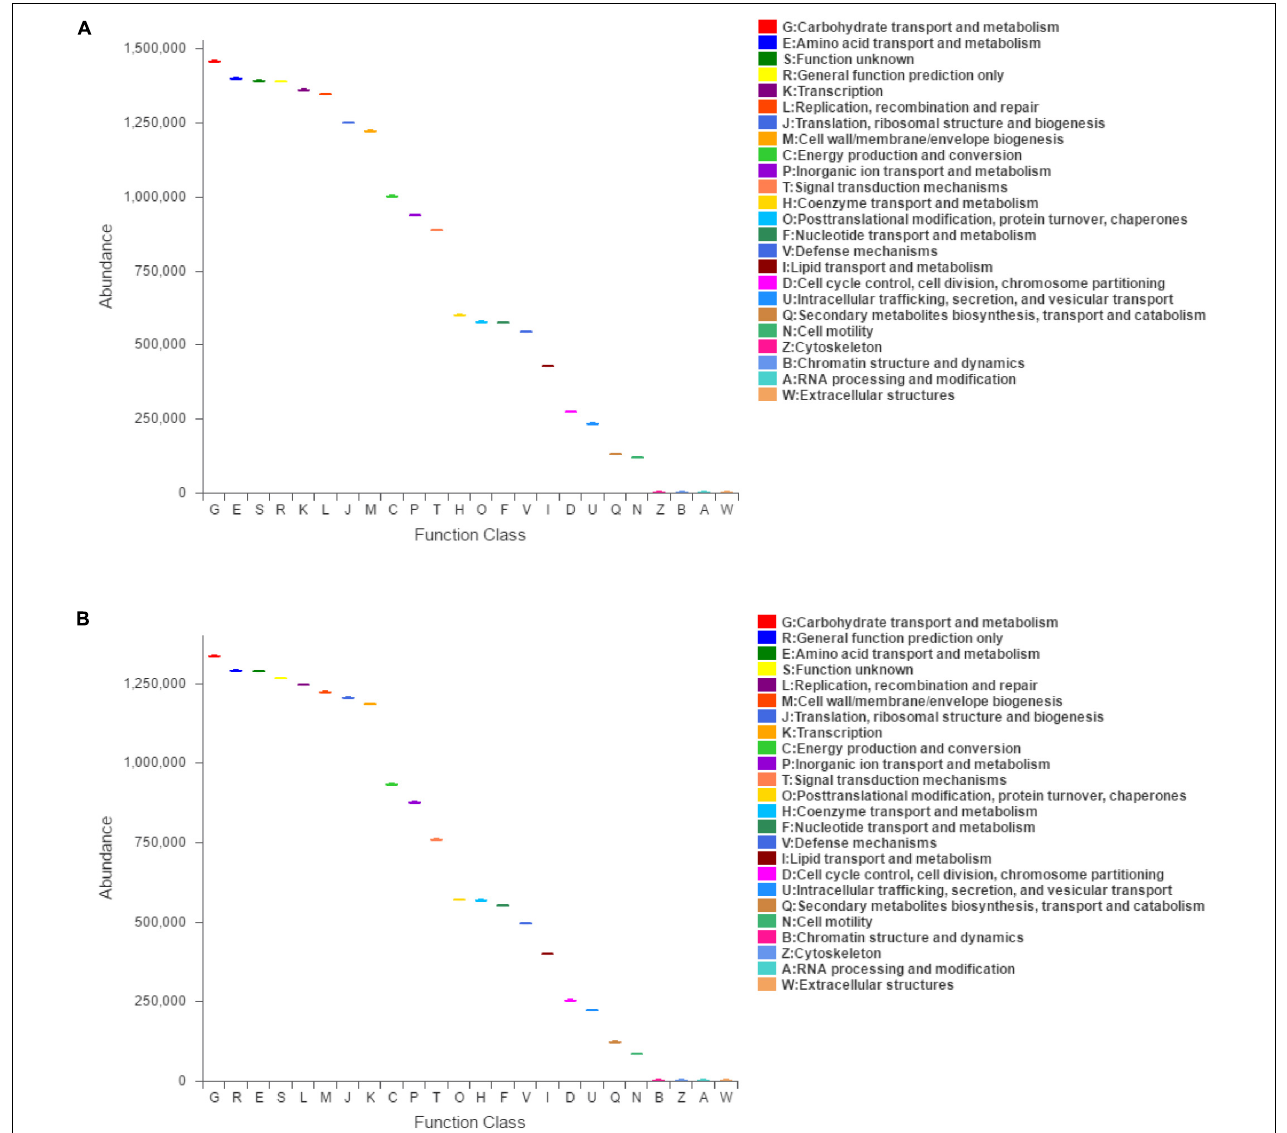
FIGURE 5 | Clusters of orthologous groups (COG)-predicted functional classification at 21 dpi in PCV3- (A) and sham-inoculated piglets (B) . V and C letters denote PCV3- and sham-inoculated piglets, respectively. The X and Y -axes represent COG functional numbers and functional abundance. Boxes denote the interquartile range